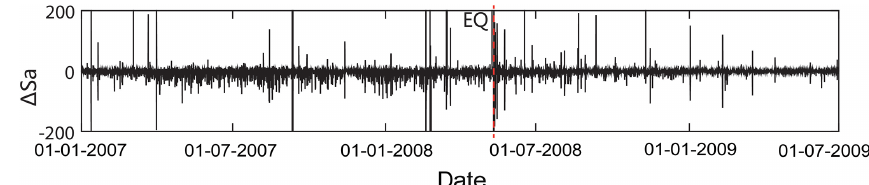
Figure 3. High-frequency areal strain at Guza from 1 January 2007 to 30 June